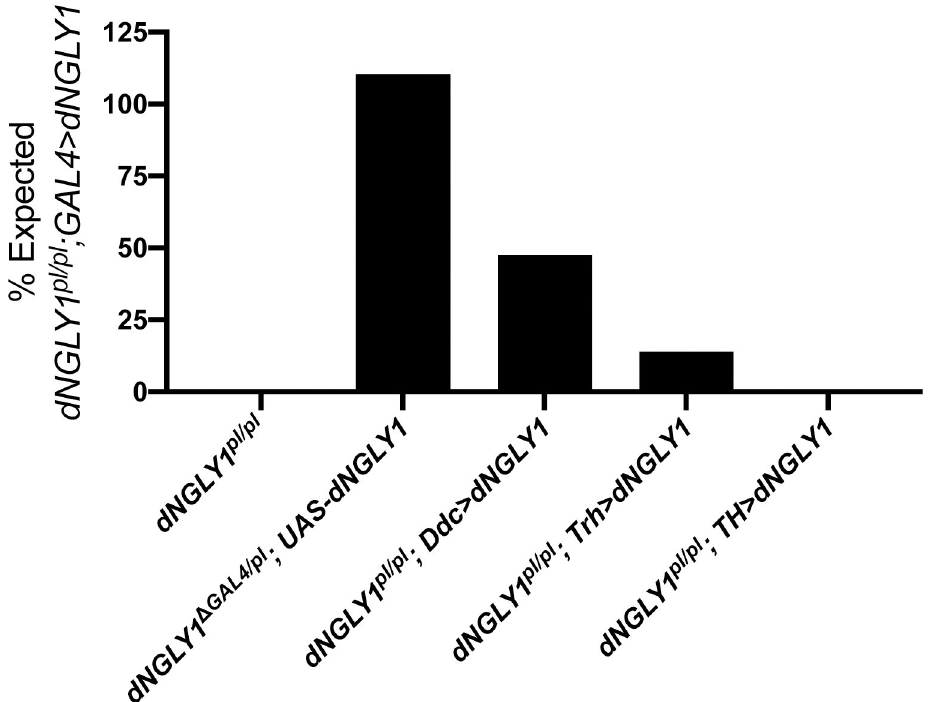
Fig 4. Expressing dNGLY1 in dopamine and/or serotonin neurons rescues lethality in dNGLY1 pl/pl flies. The GAL4/UAS system was used to express dNGLY1 in a cell-type specific pattern in otherwise dNGLY1 pl/pl flies. Expressing dNGLY1 in the endogenous expression pattern with dNGLY1 Δ GAL4 completely rescued the lethality phenotype of dNGLY1 Δ GAL4/pl flies. Expressing dNGLY1 only in dopamine and serotonin neurons with Ddc-GAL4 rescued to 47.5%. Expressing dNGLY1 in only serotonin neurons with Trh-GAL4 rescued to 13.8%, and expression in only dopamine neurons with TH-GAL4 did not rescue